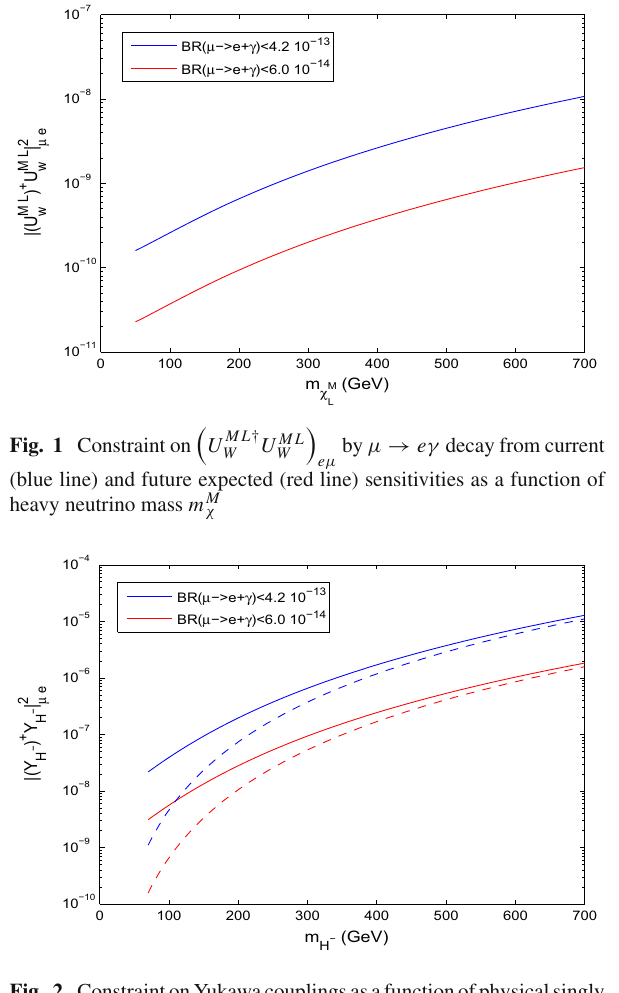
Fig. 2 ConstraintonYukawacouplingsasafunctionofphysicalsingly charged Higgs scalar mass by μ → e γ decay if only left or right sector is taken into account, for new neutrino masses of 150 GeV (solid lines) and 10 − 9 GeV (dashed lines)